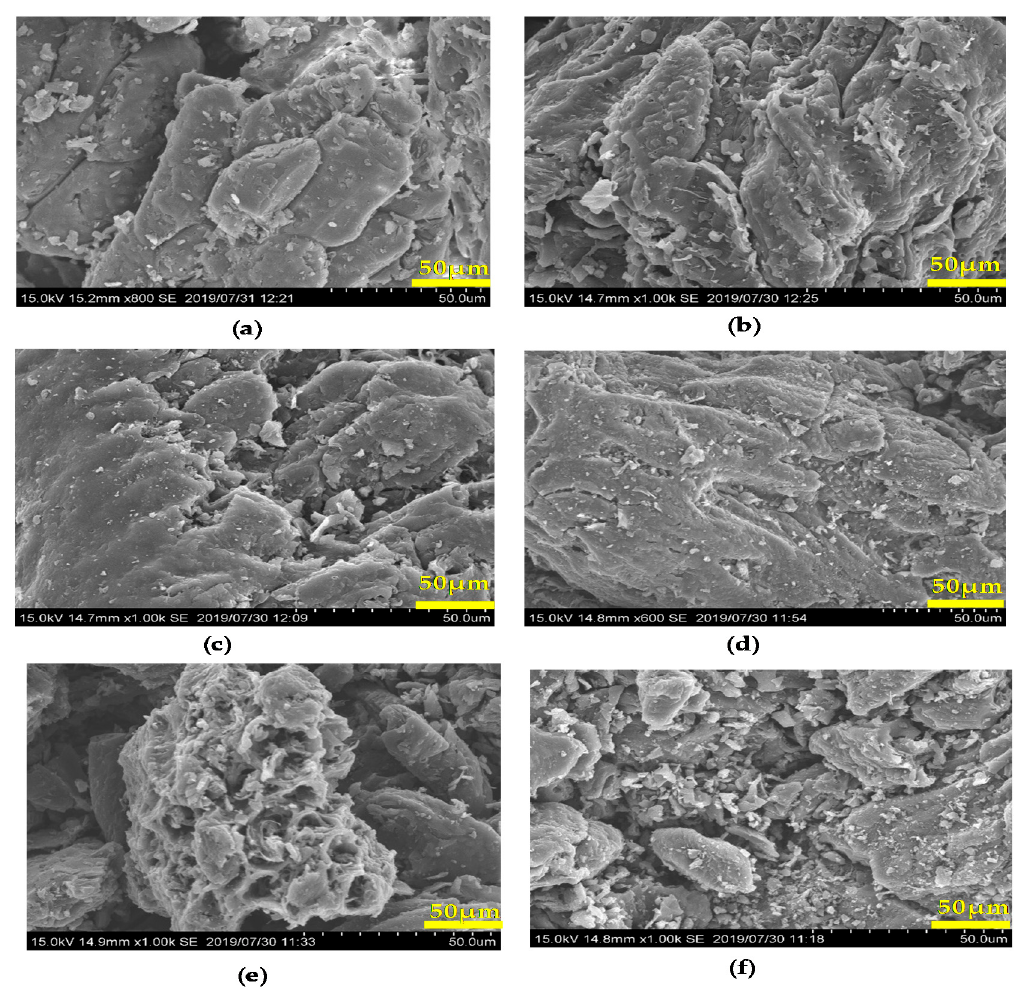
Figure 4. SEM results from coconut shells: ( a ) coconut shell and bio-char, ( b ) 400 °C, ( c ) 500 °C, ( d ) 600 °C, ( e ) 700 °C, and ( f ) 800 °C.